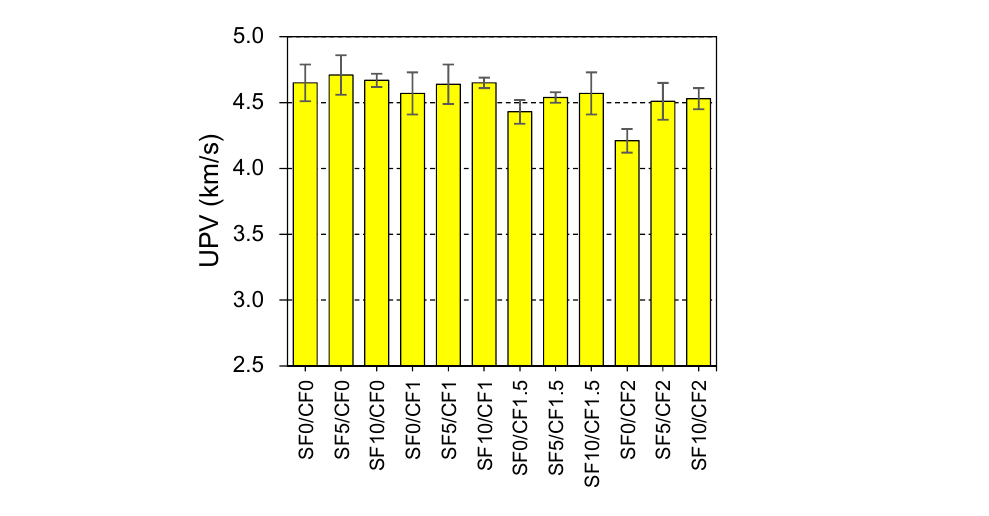
Figure 14. Correlation between corresponding values of UPV and compressive strength.